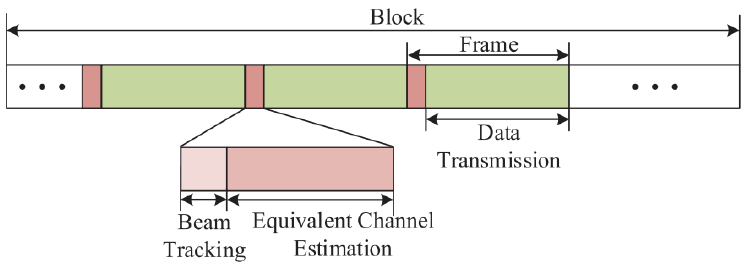
Figure 2. The frame structure for THz